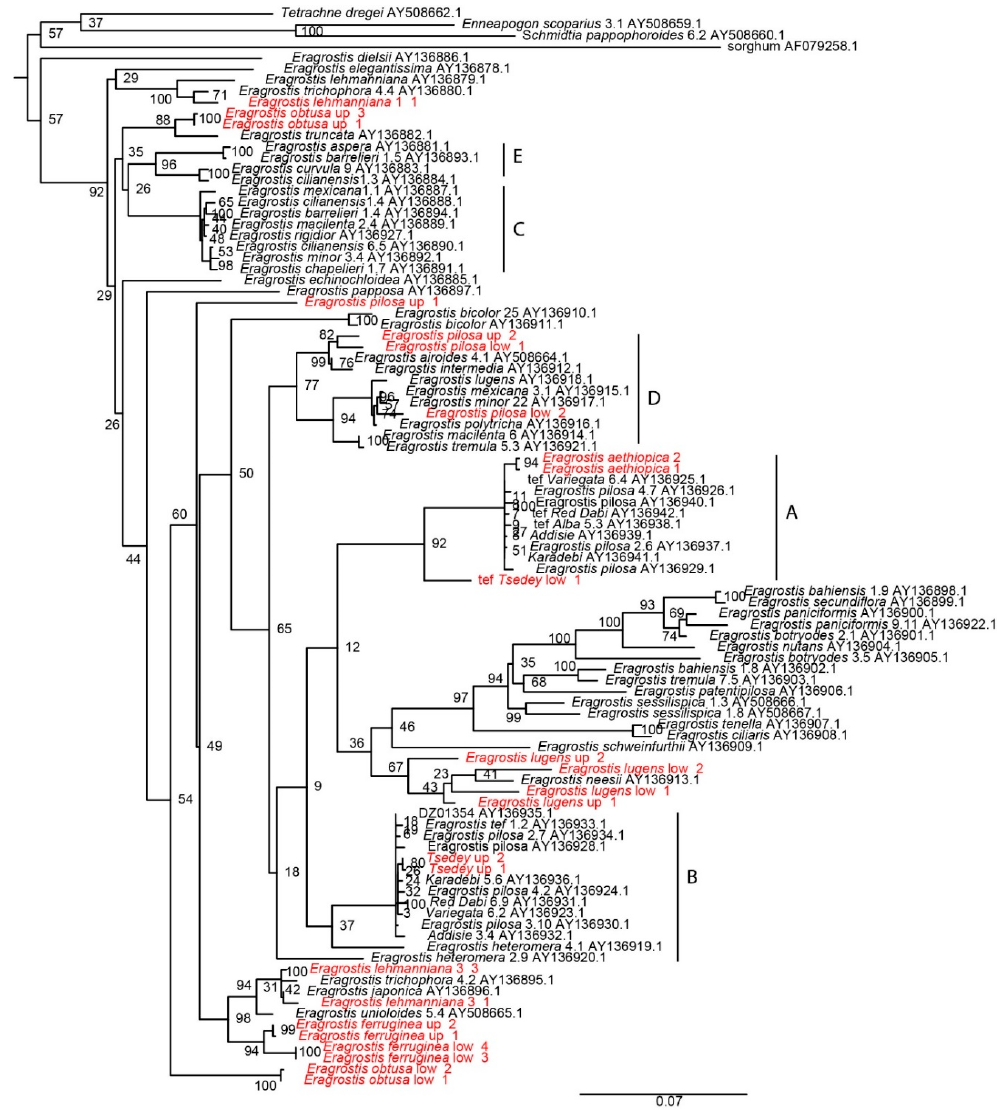
Figure 5. Phylogenetic tree constructed from partial sequences of the waxy gene obtained from the National Center for Biotechnology Information (shown in black) and cloning new sequences (shown in red). For the red sequences, the first marker indicates the band on the gel, either “low” or “up”, and the second number indicates the number of the clone. E. aethiopica had only one band and is only labeled for the clone number. The maximum likelihood tree was inferred using PhyML and the default model of HKY85 + G. The scale bar reflects evolutionary distance, measured in units of substitution per nucleotide site. Branch support was inferred using 100 rounds of bootstrapping; values are indicated. The length of the sorghum branch was shortened for visualization purposes; the branch length is 0.5354. The letters denote the subgenomes as labeled by Ingram.